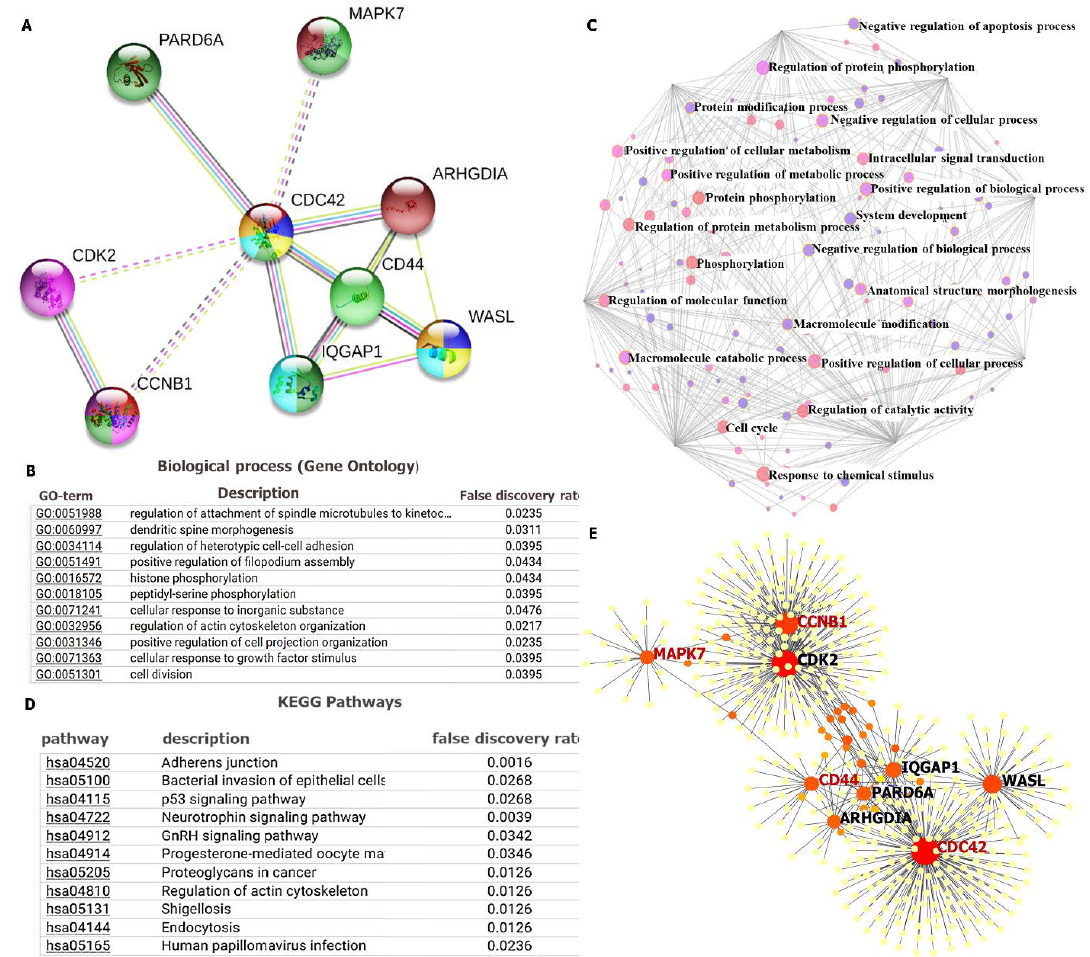
Figure 7. Protein – protein interaction (PPI) network revealed interactions among the CCNB1/CDC42/MAPK7/CD44 oncogenes in glioblastoma multiforme (GBM). ( A ) The clustering